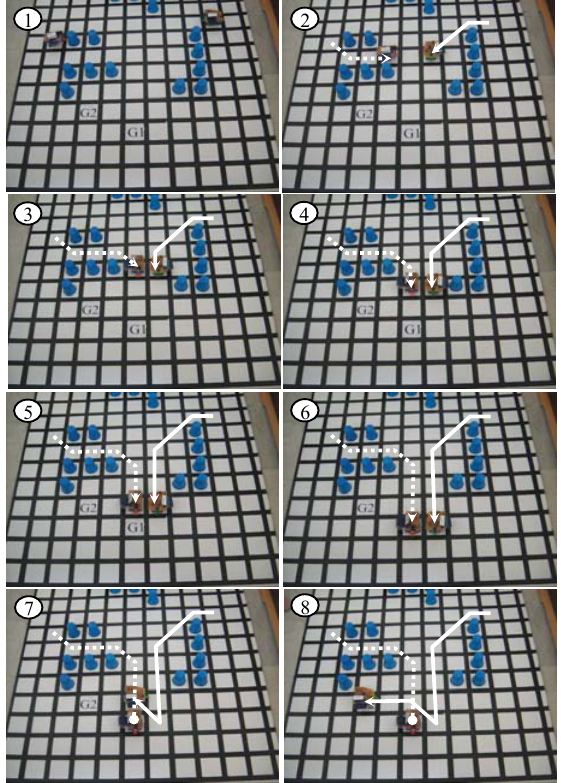
Fig.17. Eight snapshots of a two-robot test in an environment with convex obstacles. The generated path for R1 and R2 by the proposed algorithm is shown by dashed and solid white lines respectively. R2 adjusts its path in order to avoid collision with the robot R1